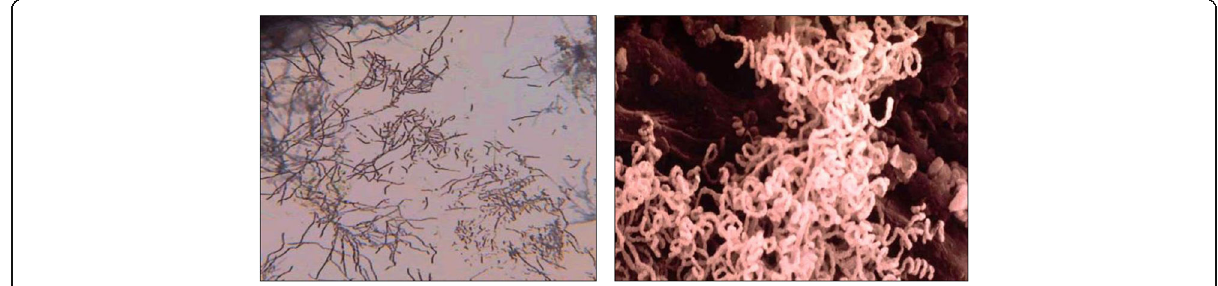
Fig. 1 Aerial mycelium of Streptomyces